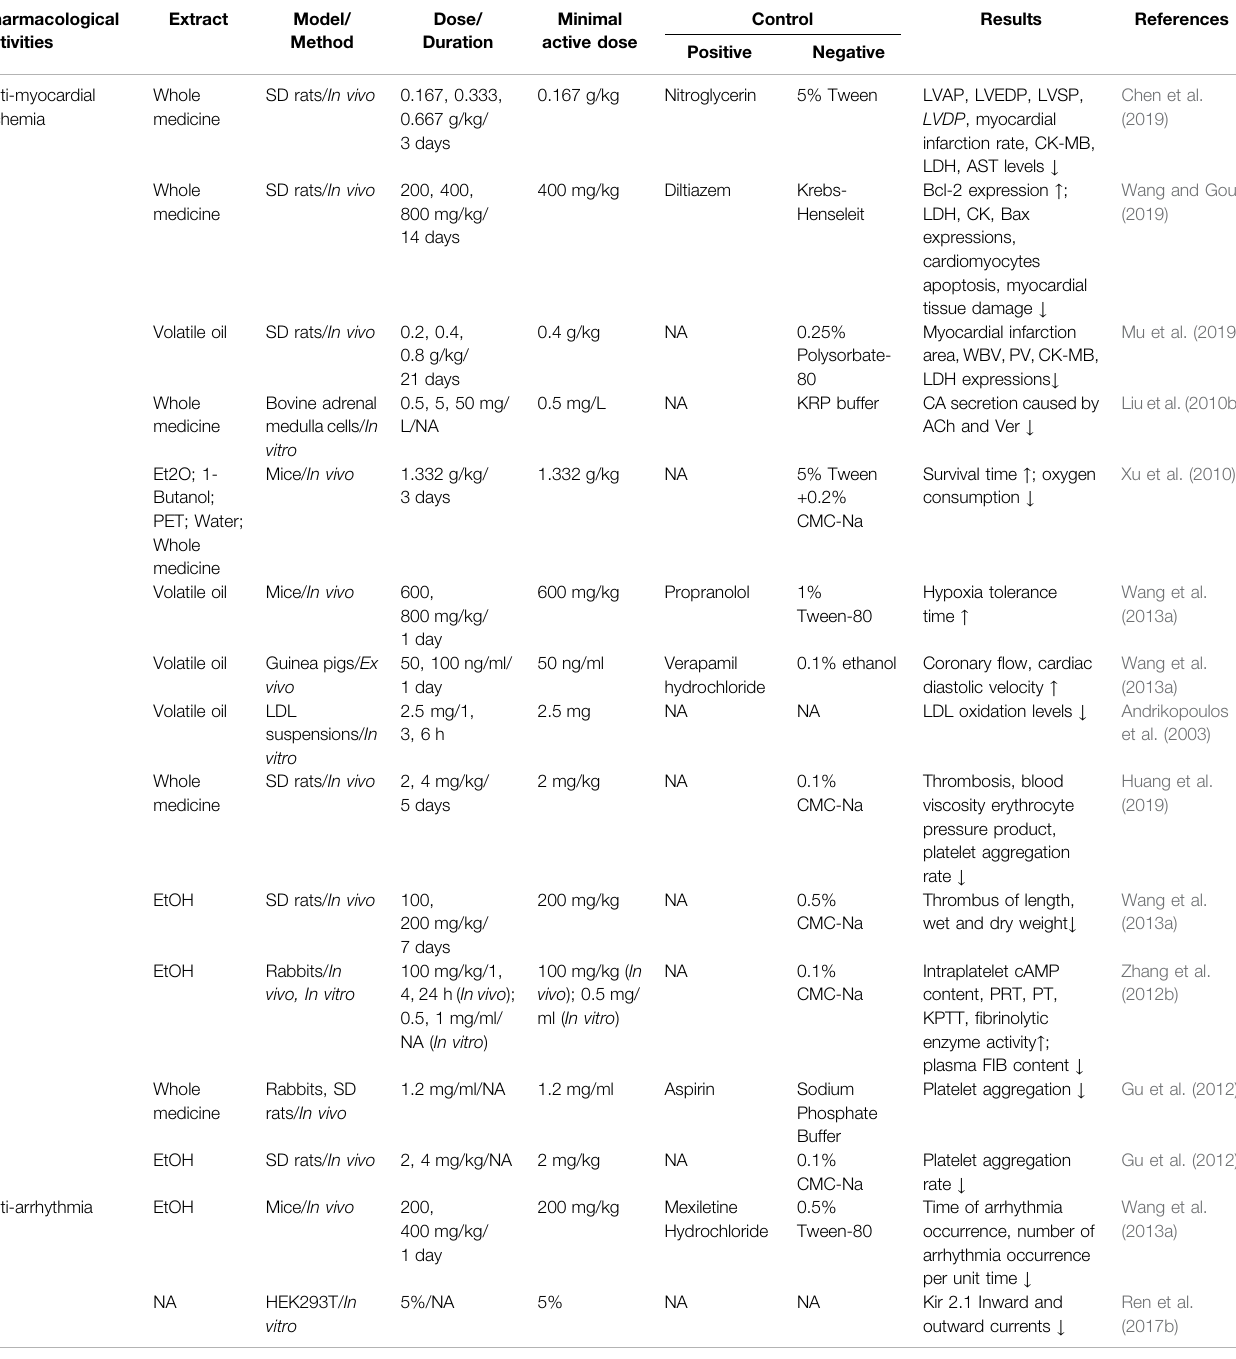
TABLE 4 | Pharmacological effects of storax on cardiovascular diseases ( ” ↓ , ” decrease; “ ↑ , ” increase). Pharmacological